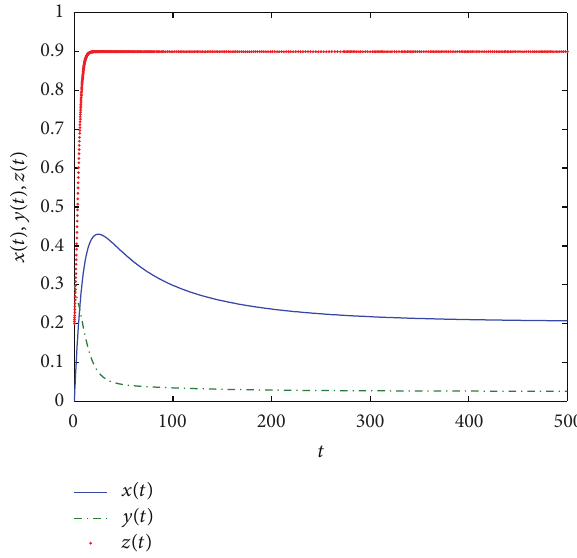
Figure 1: Parameters: 𝛽 = 0.2, 𝛼 = 0.1, 𝛾 = 0.02, 𝜇 = 0.05, 𝜔 = 0.05, 𝑐 = 0.1, and 𝛿